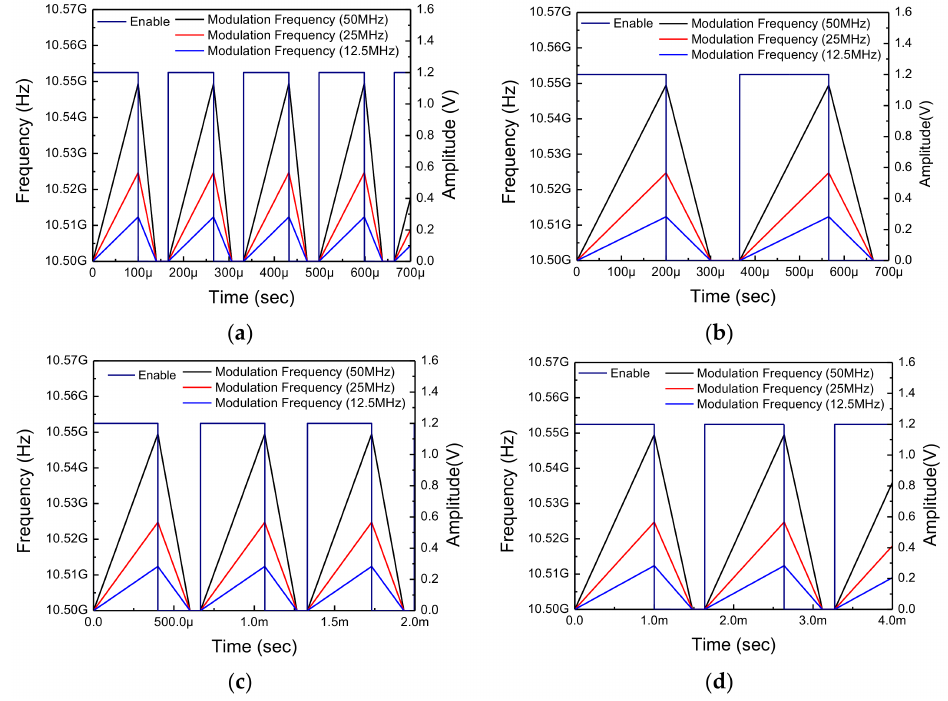
Figure 19. Various simulation results of FMCW waveforms. Under the same condition that chirp bandwidth is only shown at 12.5, 25 and 50 MHz, the chirp time is varied in ( a ) 0.1 ms; ( b ) 0.2 ms; ( c ) 0.4 ms; and ( d ) 1